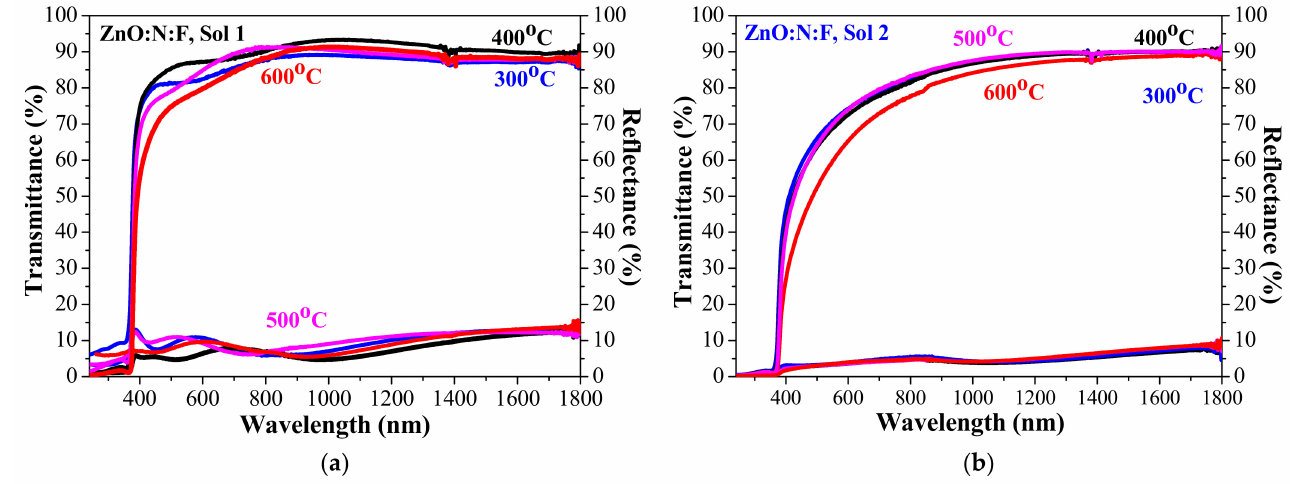
Figure 6. Transmittance and reflectance spectra of ZnO:N:F films, deposited from ( a ) Sol 1 and ( b ) Sol 2, thermally treated at different annealing